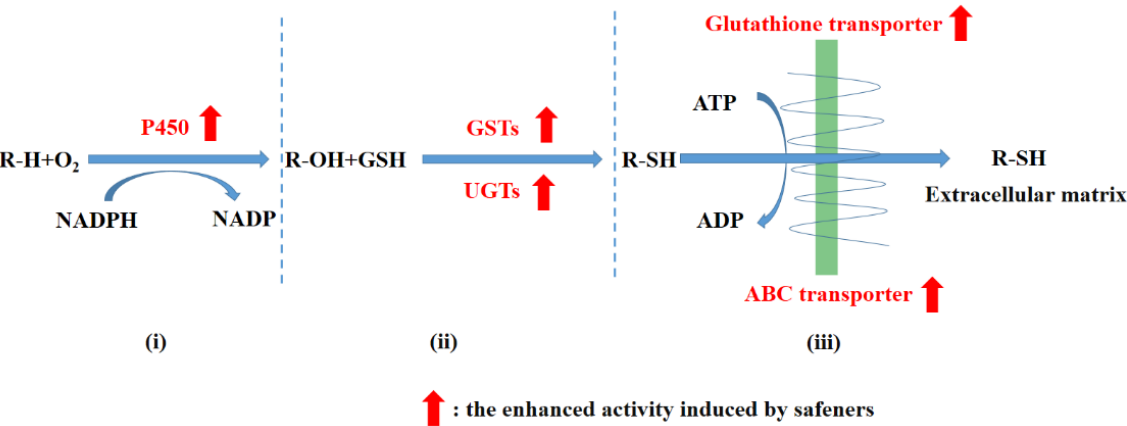
Figure 1. Herbicide metabolism stages ( i – iii ) and enhancement of metabolism induced by safeners in crop plants.